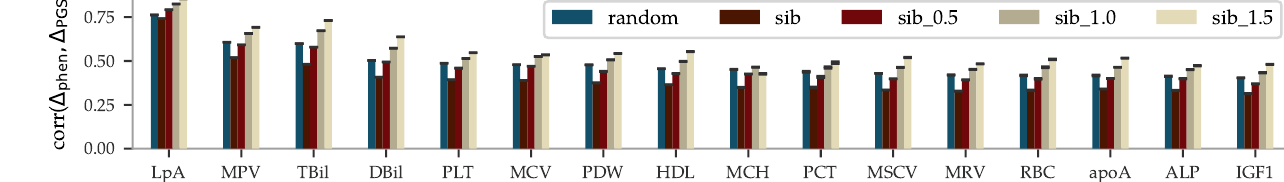
Figure 4. Sibling comparisons of correlation between difference in phenotype and difference in PGS, i.e., corr ( ∆ phen , ∆ PGS ) , show that most of the correlation is also retained for pairs that share similar environmental backgrounds. UKBs ∼ 40 k siblings of European ancestry were paired either randomly or as genetic siblings and were used as a test set. The correlations between the pairs’ differences in phenotype and their differences in PGS was then calculated for each biomarker, ordered above from strongest to weakest correlation. The error bars indicate ± the standard deviations for 5 predictors trained on slightly different training sets. The additional three bars labeled sib 0.5, sib 1.0, and sib 1.5, are the results when restricting to siblings with phenotype differences larger than 0.5, 1, and 1.5 standard deviations, respectively. Two siblings are likely to have more similar environmental backgrounds than random pairs, affecting the similarity of late-life biomarker measurements independently from (direct) genetic effects. This could explain the decreased correlation for siblings as compared to random pairs. Yet, the remaining correlations are strong evidence that the predictors capture some direct genetic effects on the biomarkers. The comprehensive figure for all biomarkers can be found in the Supplementary